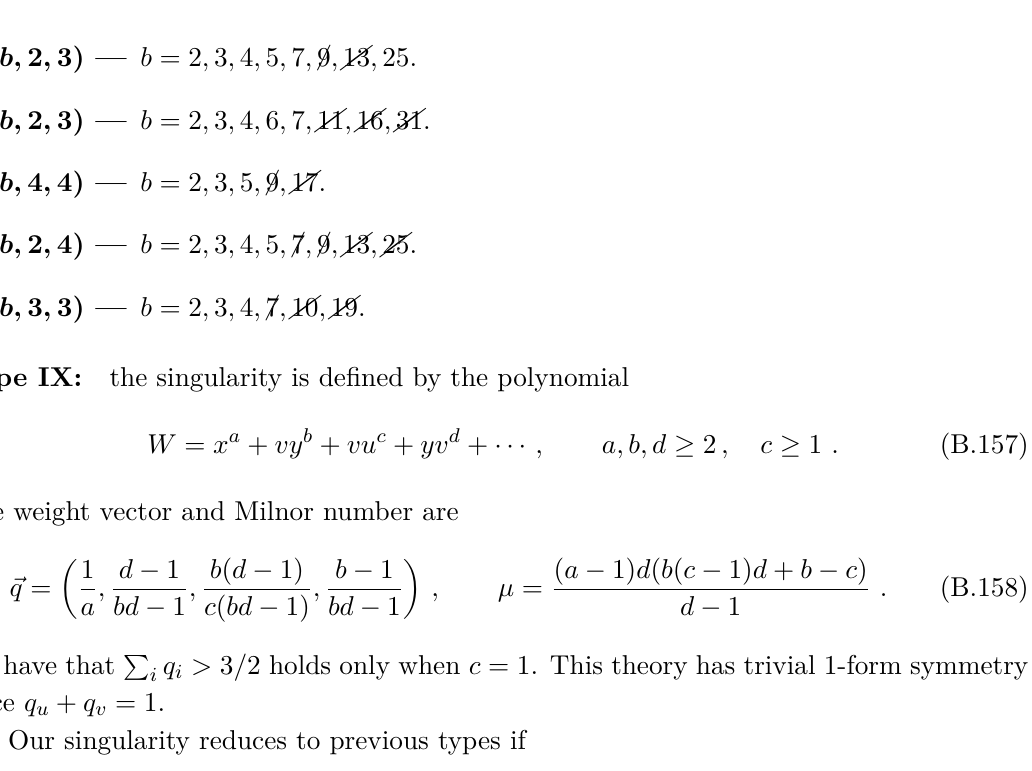
Table 15 . Infinite sequences of type IX singularities. The gray entries are either reducible to previous types or have c = 1 , which gives trivial 1-form symmetry. This table is adapted from